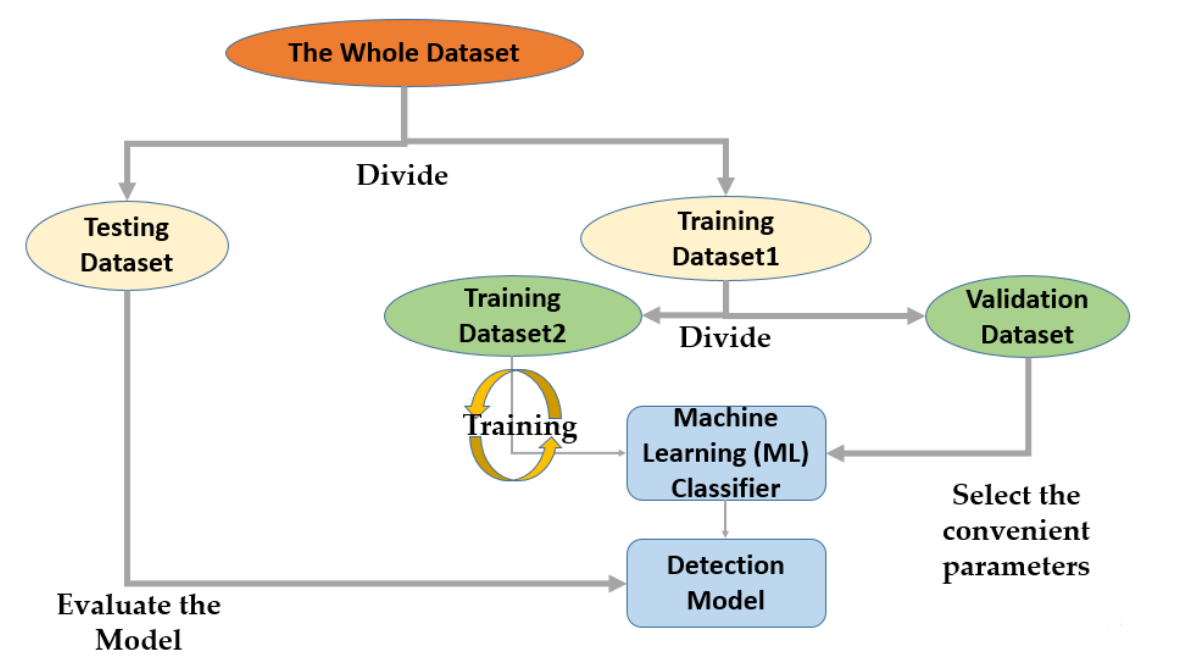
Figure 5. “Hold-Out” validation technique. Table 1. The total number of images after the division of the data into training, validation, and test- ing